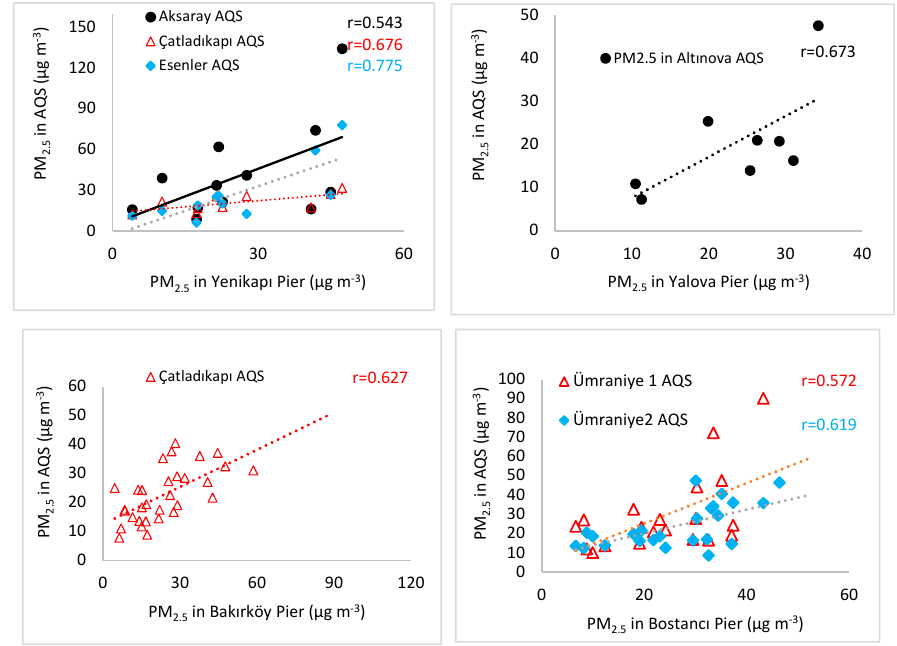
Figure 4. Scatterplots and Pearson correlation coefficients between the mean concentration of PM 2.5 in fixed air quality station (AQS) and the mean concentration of PM 2.5 at the piers (Yenikapı, Yalova, Bakırköy, and Bostancı).